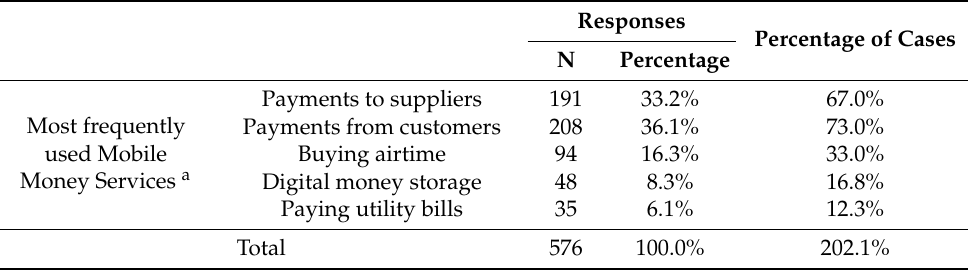
Table 3. Types of Mobile Money Services most frequently used by the respondents.